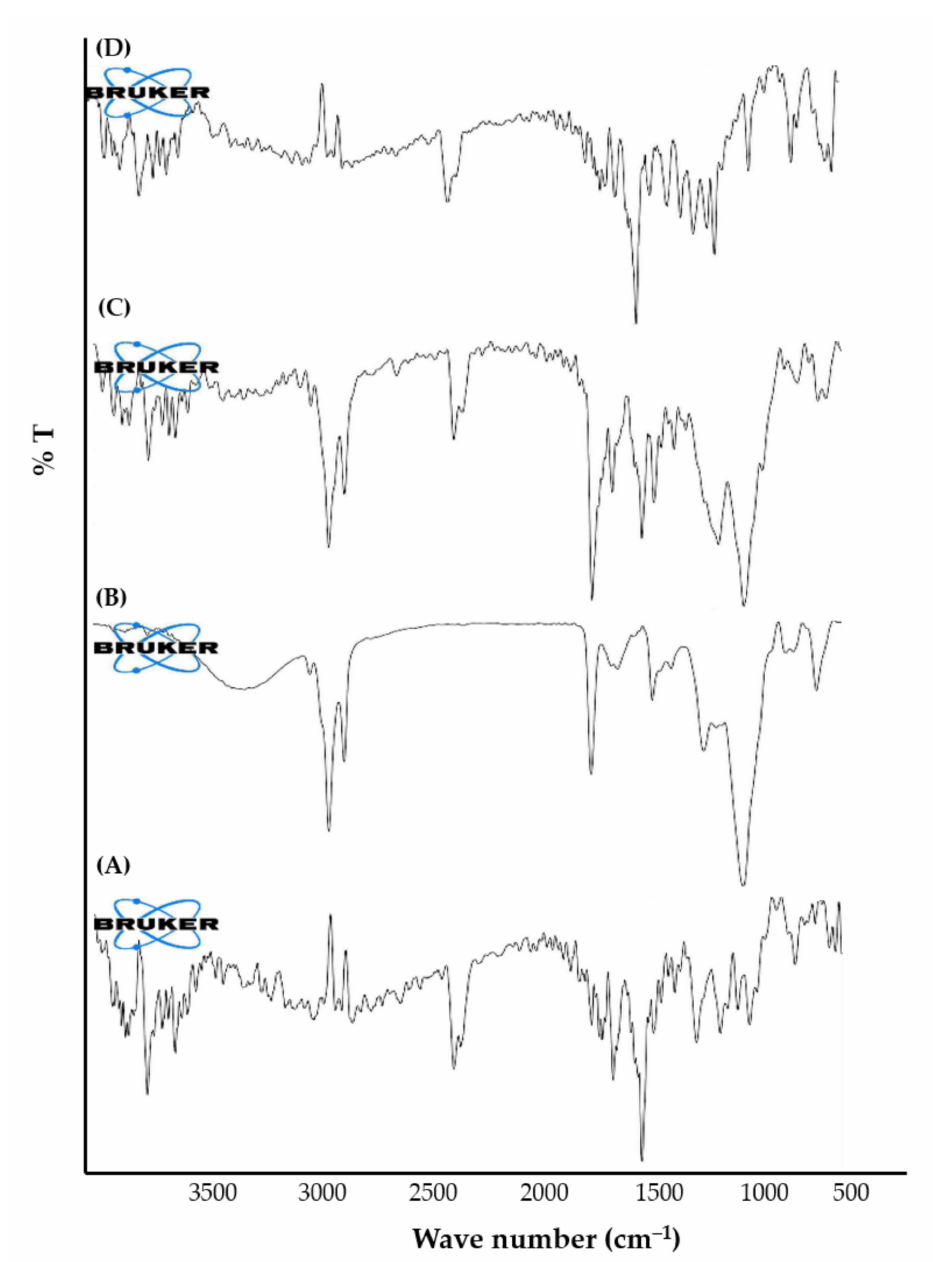
Figure 3. FTIR spectra of ( A ) silymarin; ( B ) SPC; ( C ) physical mixture of silymarin + SPC; and ( D ) optimized silymarin phytosomal